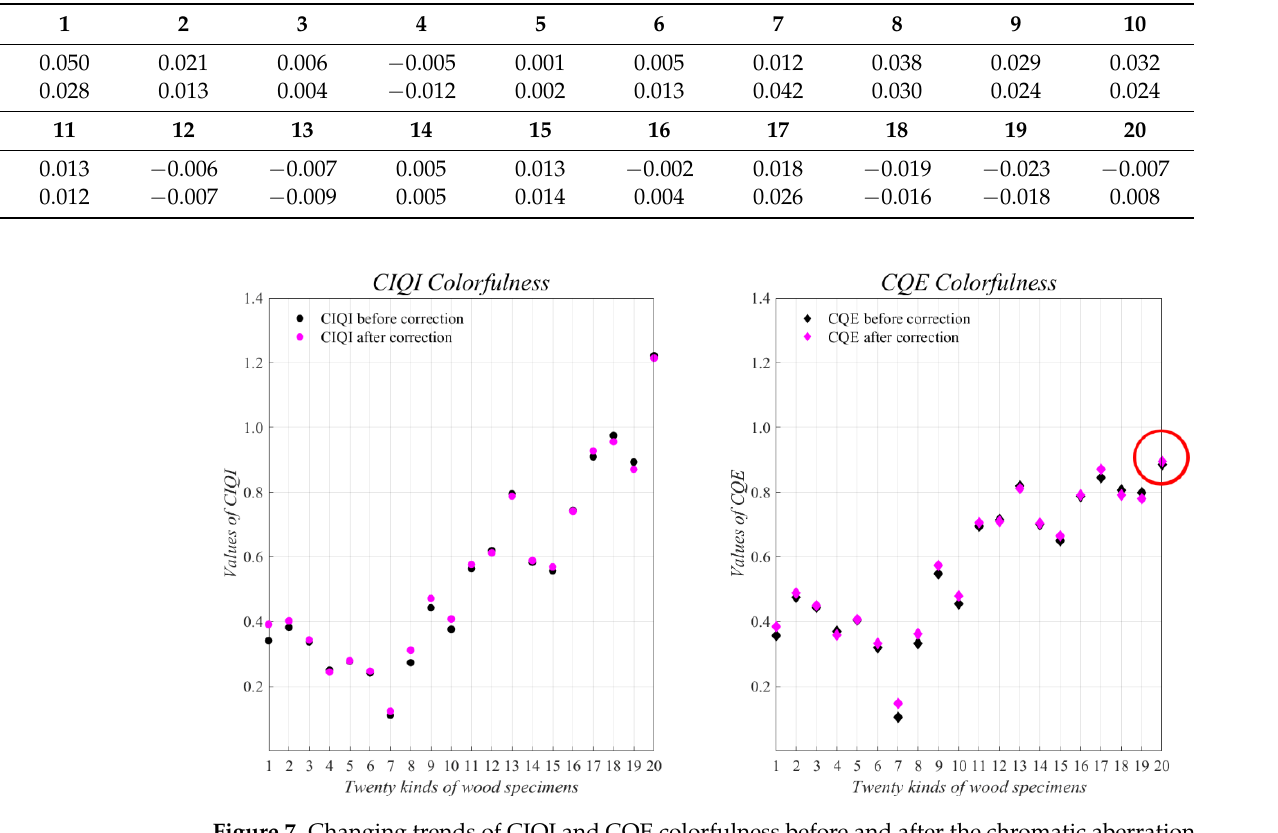
Figure 7. Changing trends of CIQI and CQE colorfulness before and after the chromatic aberration correction.